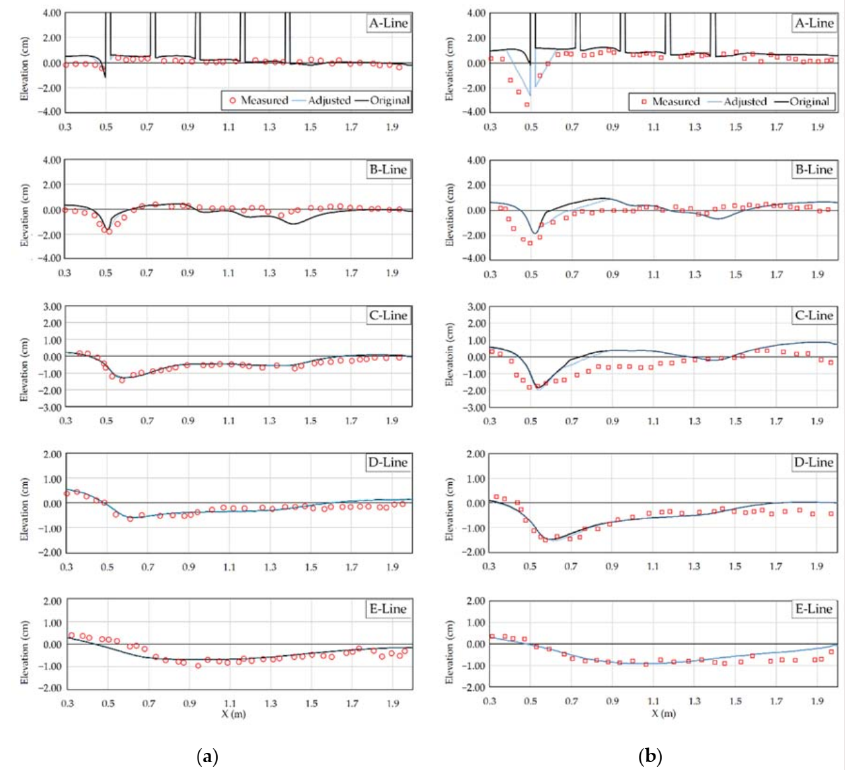
Figure 17. Comparison of the measured and simulated bed profiles from the A-line to the E-line: ( a ) case G4a and ( b ) case